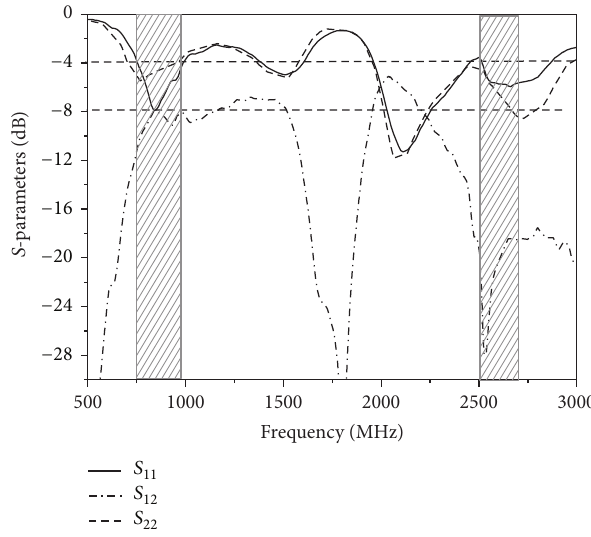
GSM850/900, and LTE band 7, simultaneously. According to